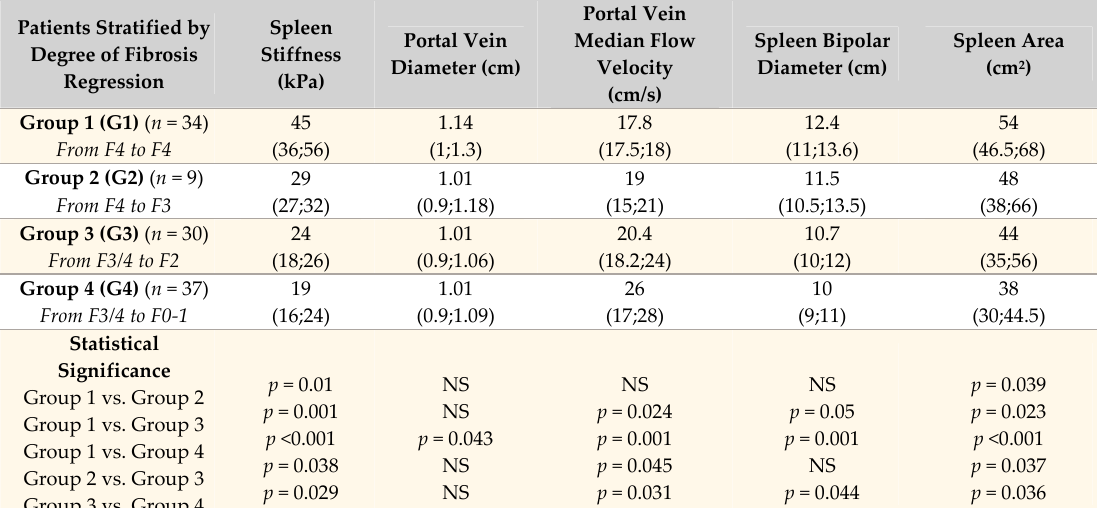
Table 3. Patients were stratified into four groups based on liver fibrosis downstaging according to liver stiffness values. Values were reported according to their Median and Quartile 1-Quartile 3, Me (Q1;Q3). Inter-group differences were evaluated using Mann–Whitney U test. NS: not statistically significant